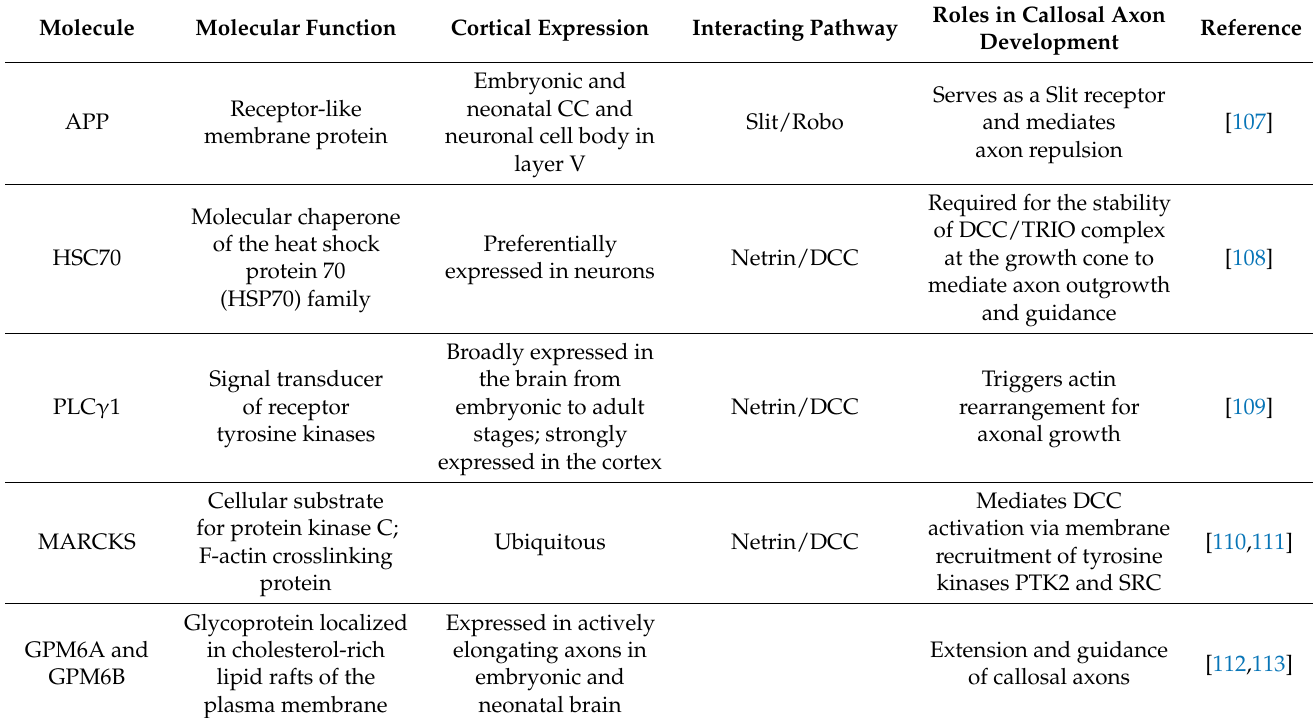
Table 2. List of newly reported molecules that play roles in CPN axon guidance.